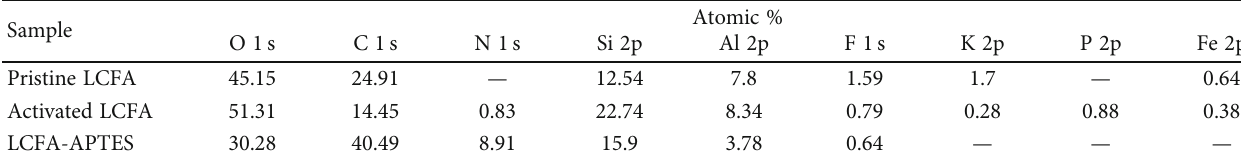
Table 2: Atomic percentages of the pristine and surface functionalized